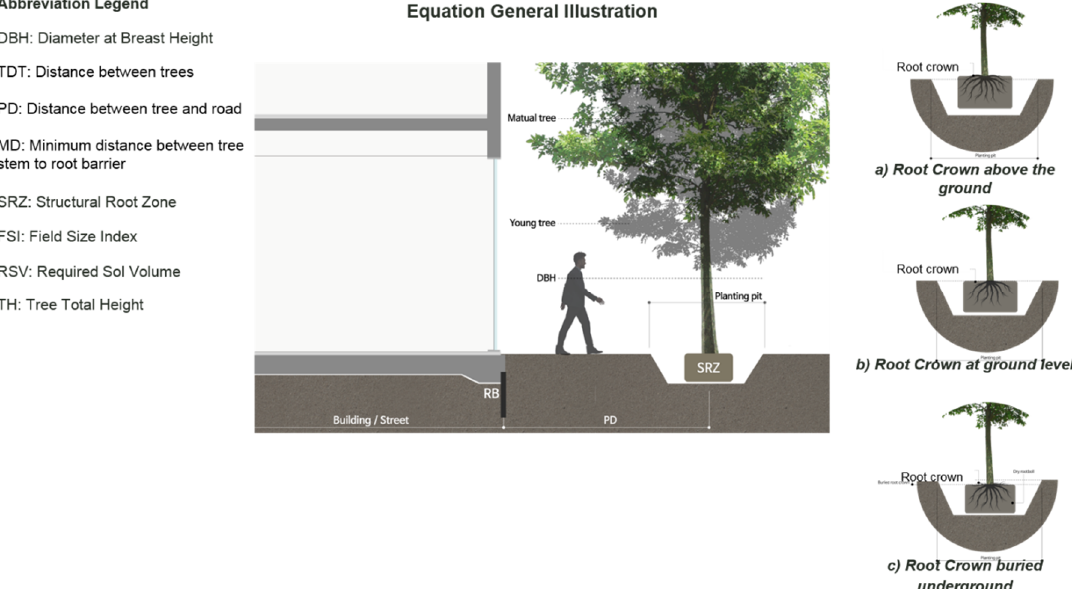
Figure 2. An illustration of T-Rule module rules and regulations including root crown positioning scenarios: ( a ) Root crown position above the ground level illustration; ( b ) Root crown level matches the ground level illustration; and ( c ) Root crown buried underground illustration.